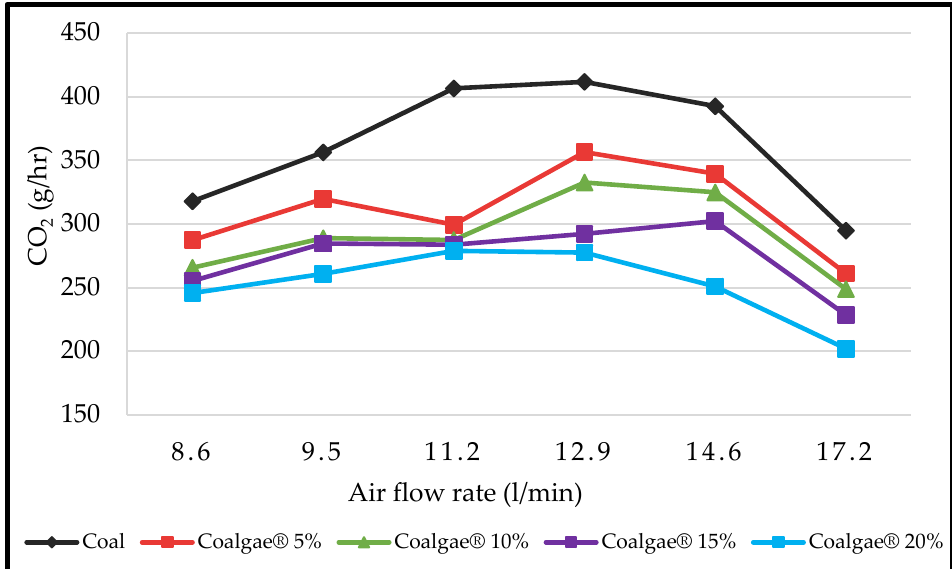
Figure 5. Effect of air flow rate on CO 2 emissions.